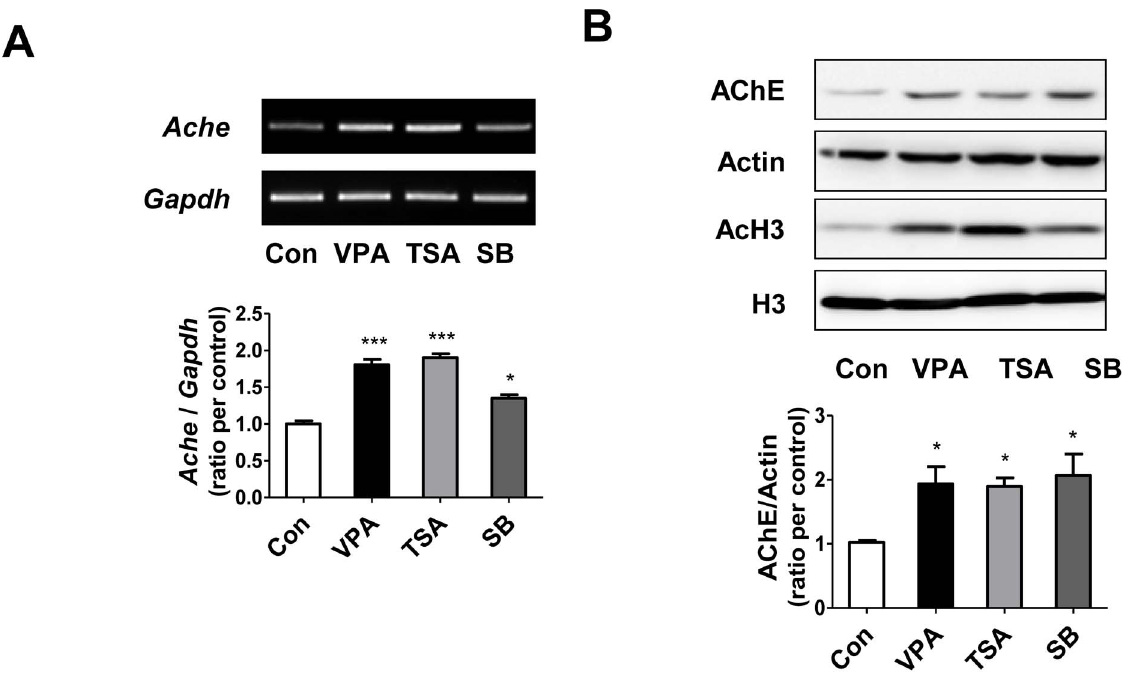
Figure 3. Histone deacetylase inhibitors increased expression of AChE in cortical NPCs from SD rat. Cortical neural progenitor cells from SD rat were treated with HDACIs: VPA (0.5 mM), TSA:Trichostatin A (0.1 m M), and SB:Sodium butyrate (0.1 mM). After 24 hours, mRNA and protein expressions were analyzed using RT-PCR (A) and Western blot (B). (A) Ache mRNA expression level was increased by both VPA and other HDACIs (N=3). (B) Protein expression of AChE was also increased by VPA and other HDACIs treatment (N=4). Data are expressed as the mean 6 S.E.M. *, ***, p , 0.05 and p , 0.001 vs. control ( Ache :Acetylcholinesterase mRNA, Gapdh :GAPDH mRNA, AChE:Acetylcholinesterase, AcH3:acetylated Histone H3, H3:Histone H3, VPA:valproic acid, TSA:Trichostatin A, SB:Sodium